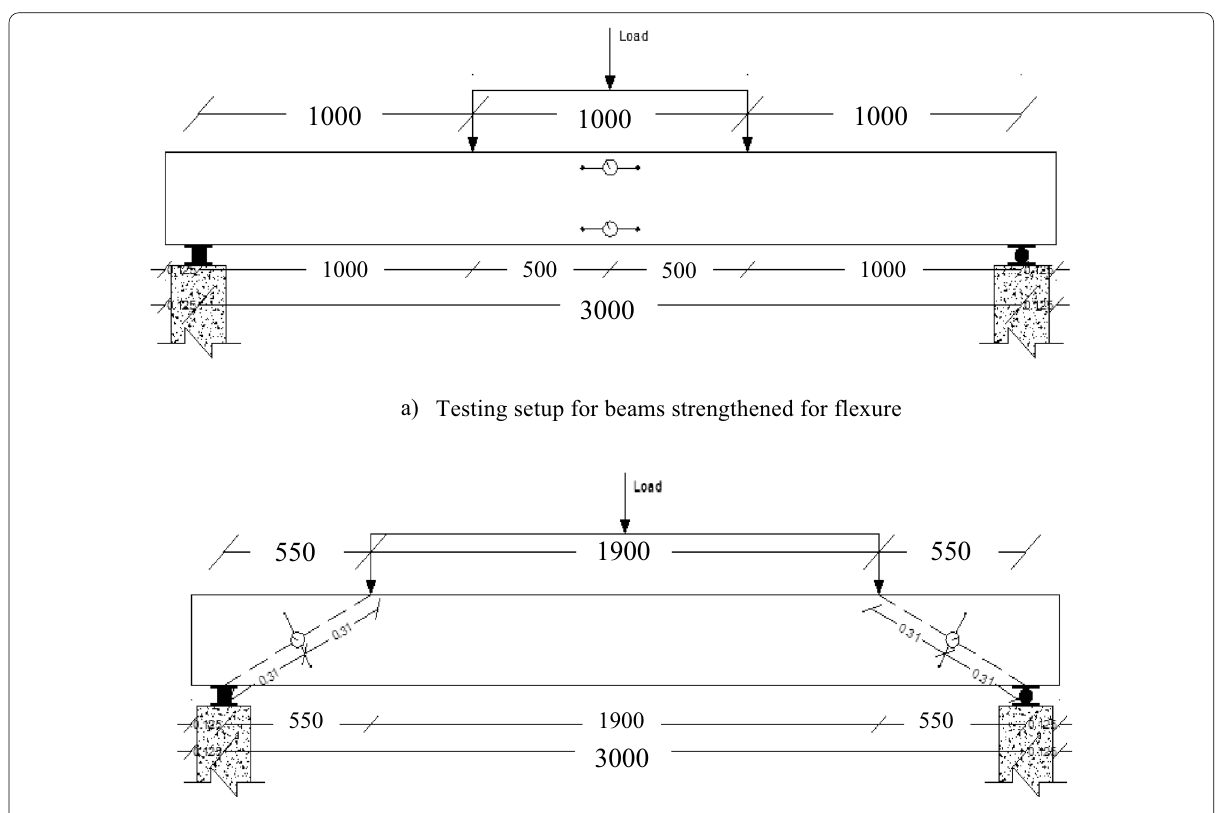
Fig. 7 LVDT arrangement for crack width measurements in studied